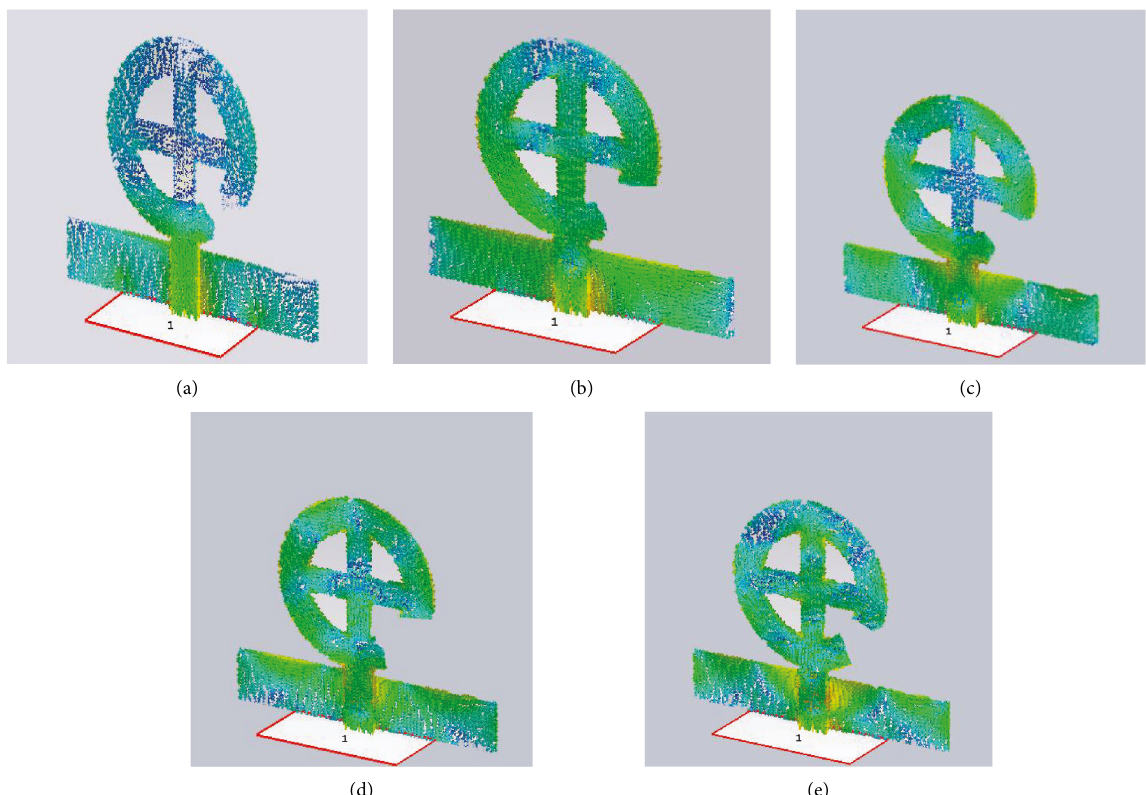
Figure 9: Distribution of surface current at various resonating frequencies: (a) 2.64GHz. (b) 4.87GHz. (c) 7.86 GHz. (d) 10.74GHz. (e) 13.67GHz.